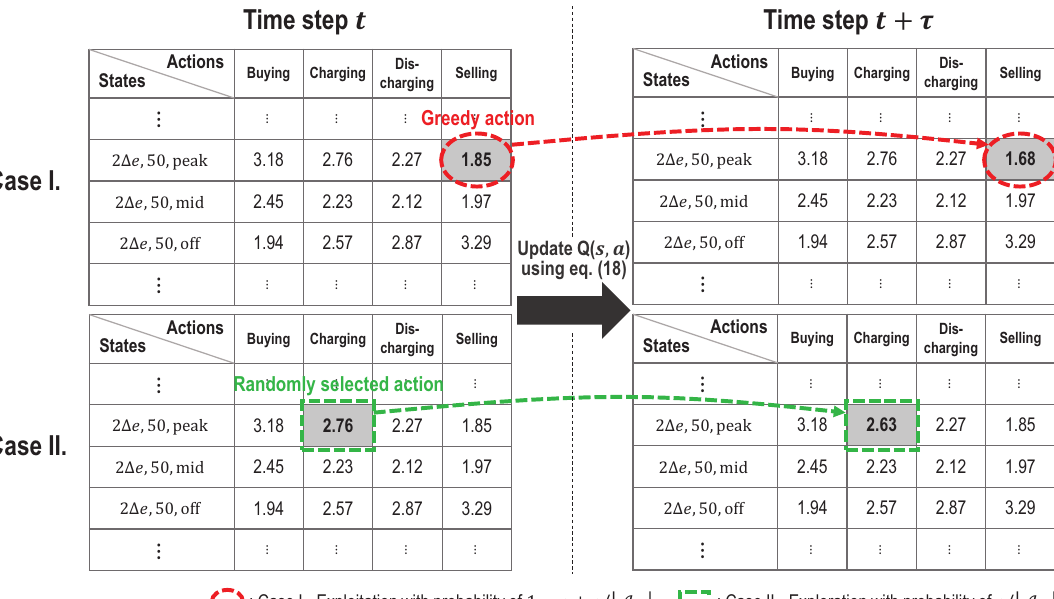
Figure 2. Simplified example of Q-table